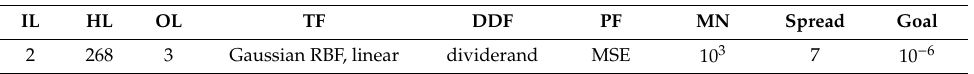
Table 1. RBF-ANN parameters for an optimized model of temperature-frequency dependence of